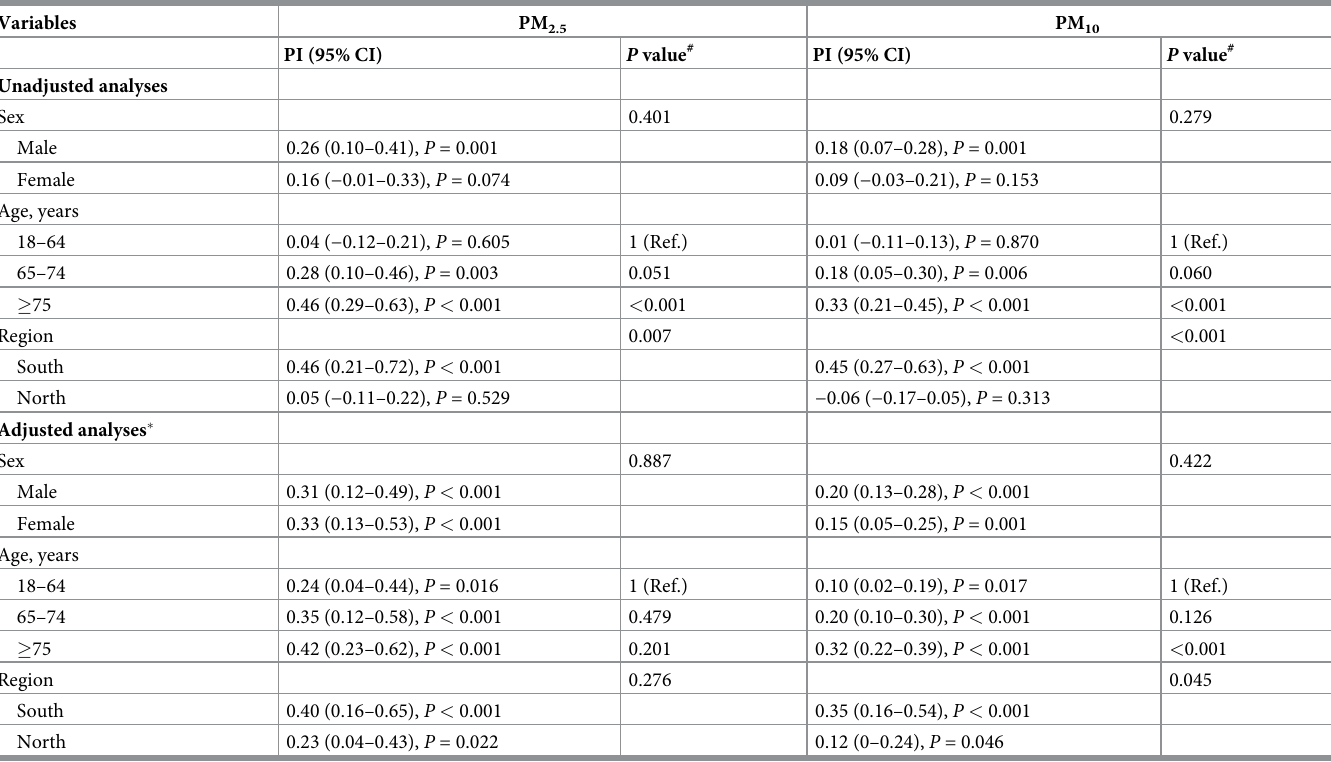
Table 4. National-average percentage increase (PI) with 95% CI in daily hospital admissions for pneumonia associated with a 10 μ g/m 3 increase in PM 2.5 and PM 10 concentrations (lag 0–2), stratified by sex, age, and geographical region.